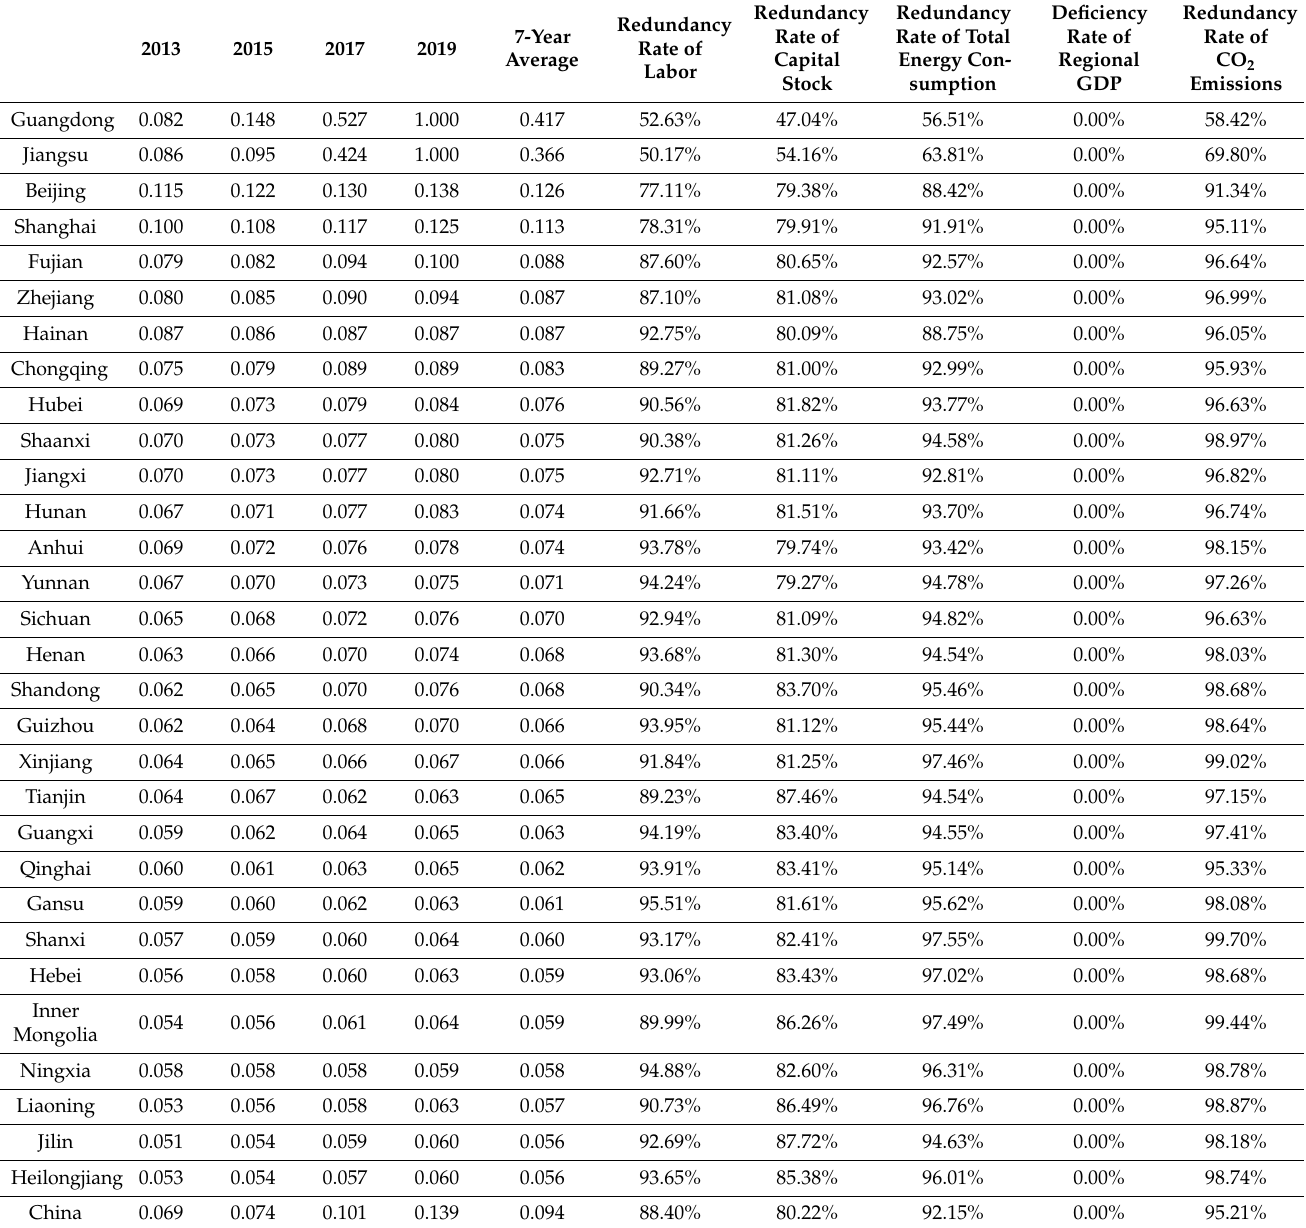
Table 5. Evaluation results of low carbon economic efficiency value in China from 2013 to